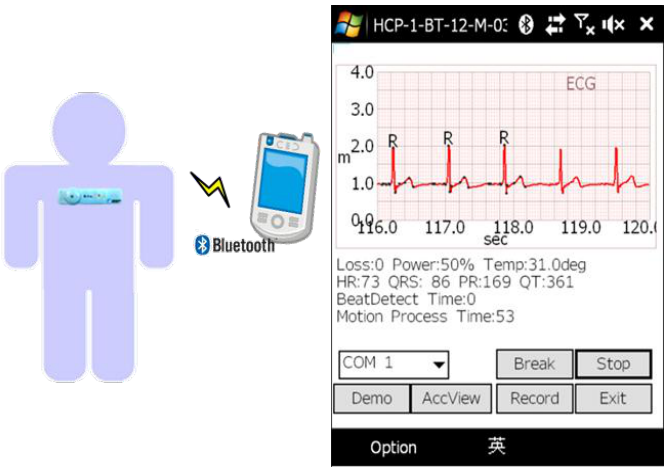
Figure 14. The graphic user interface and algorithm implementation for a mobile healthcare system.